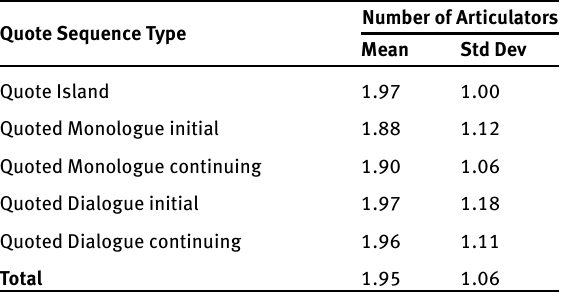
Table 5: Bodily indicators of character perspective in initial and non-initial utterances in the three types of quote sequences (means and standard deviations for the occurrences of all four